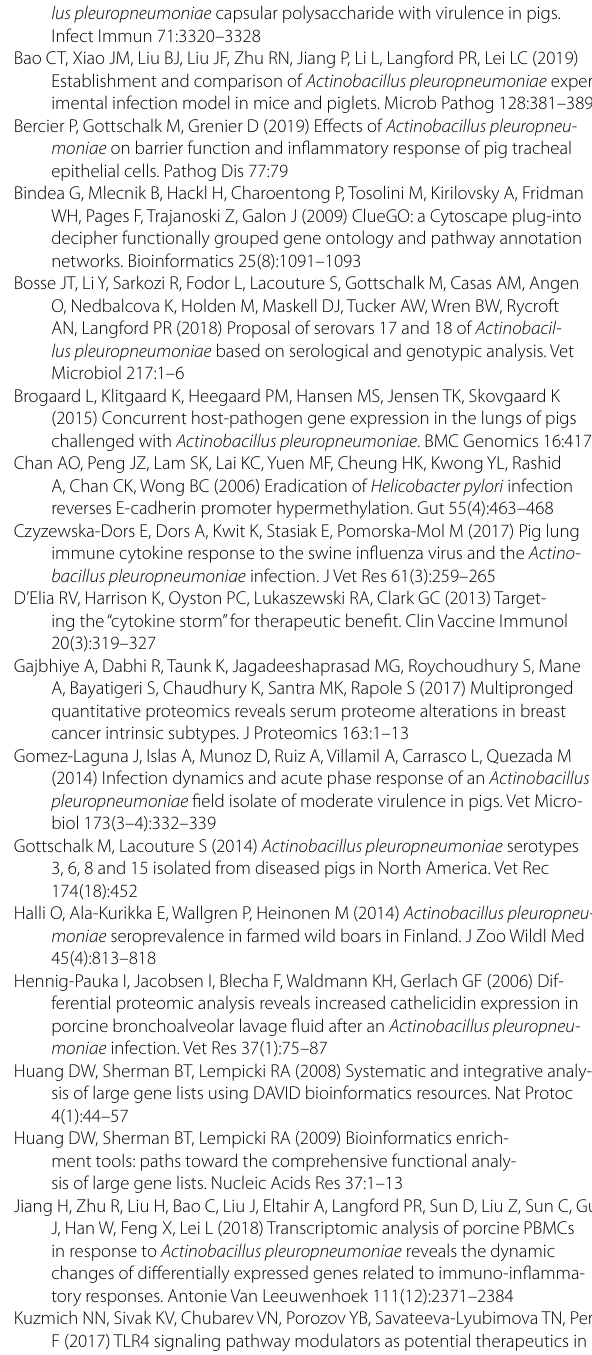
Additional file 3: Table. S3. Representative up-regulated proteins in the serum of the “S120-Vs-S24” stage with a 2.0-fold change. Additional file 4: Table. S4. Representative down-regulated proteins in the serum of the “S24-Vs-S0” stage with a 2.0-fold change. Additional file 5: Table. S5. Representative down-regulated proteins in the serum of the “S120-Vs-S0” stage with a 2.0-fold change. Additional file 6: Table. S6. Representative down-regulated proteins in the serum of the “S120-Vs-S24” stage with a 2.0-fold